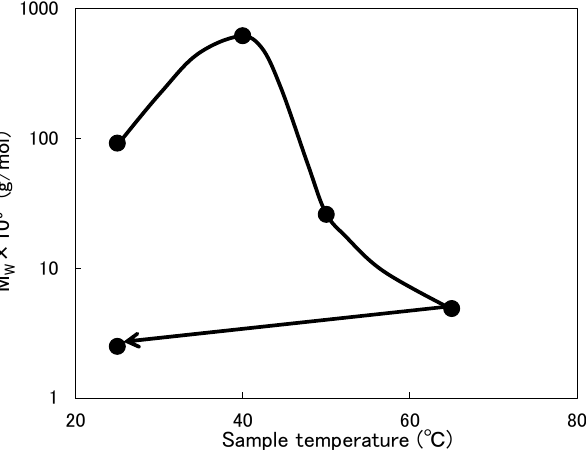
Figure 9. Relationship between sample temperature and M W (surfactant: E-212 with DBTL).